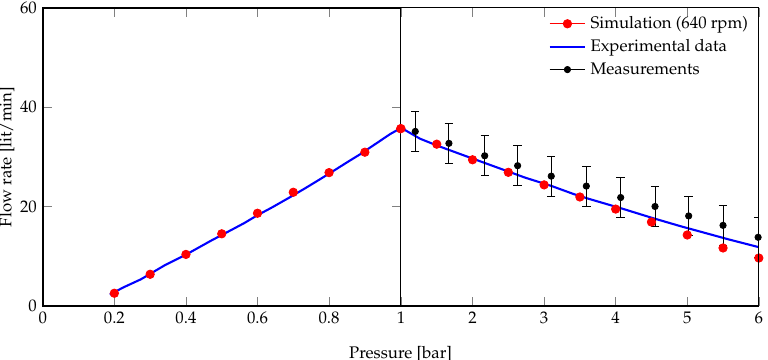
Figure 8. The flow rate profile against pressure; the red circle indicates the simulation results for the speed of 640 rpm, the blue line indicates the manufacturer data, and the black circle indicates the results from the experimental data that performed in Figure 7.